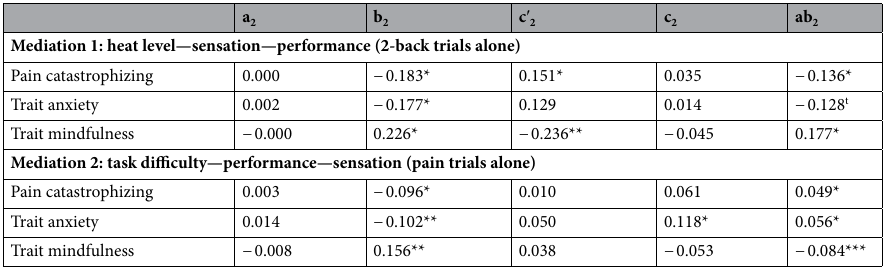
Table 2. Standardized coefficients of moderated multilevel mediations. Standardized regression coefficients for 2nd-level threat-sensitivity moderators. Coefficients are tested on individual first-level mediations depicted in Fig. 3; *** p < 0.001, ** p < 0.01, * p < 0.05, t p < 0.07; Mediation path subscript notation previously used elsewhere 21